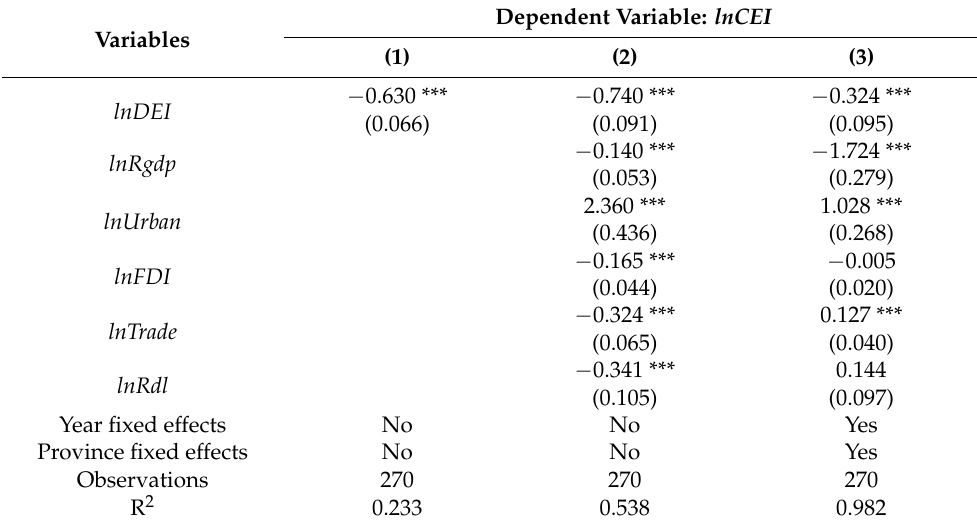
Table 5. The effect of digital economy on carbon emission intensity.